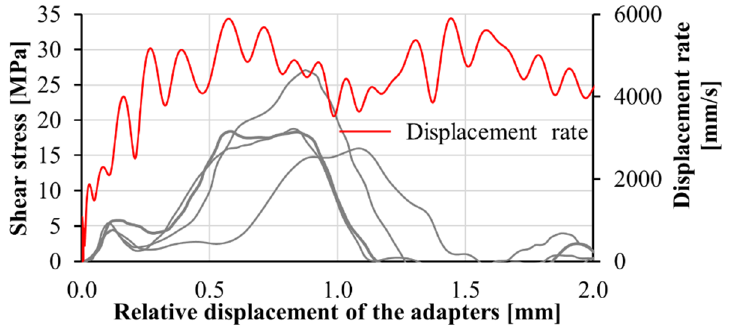
Figure 17. Shear stress versus displacement curves obtained in the confined impact shear tests on M1